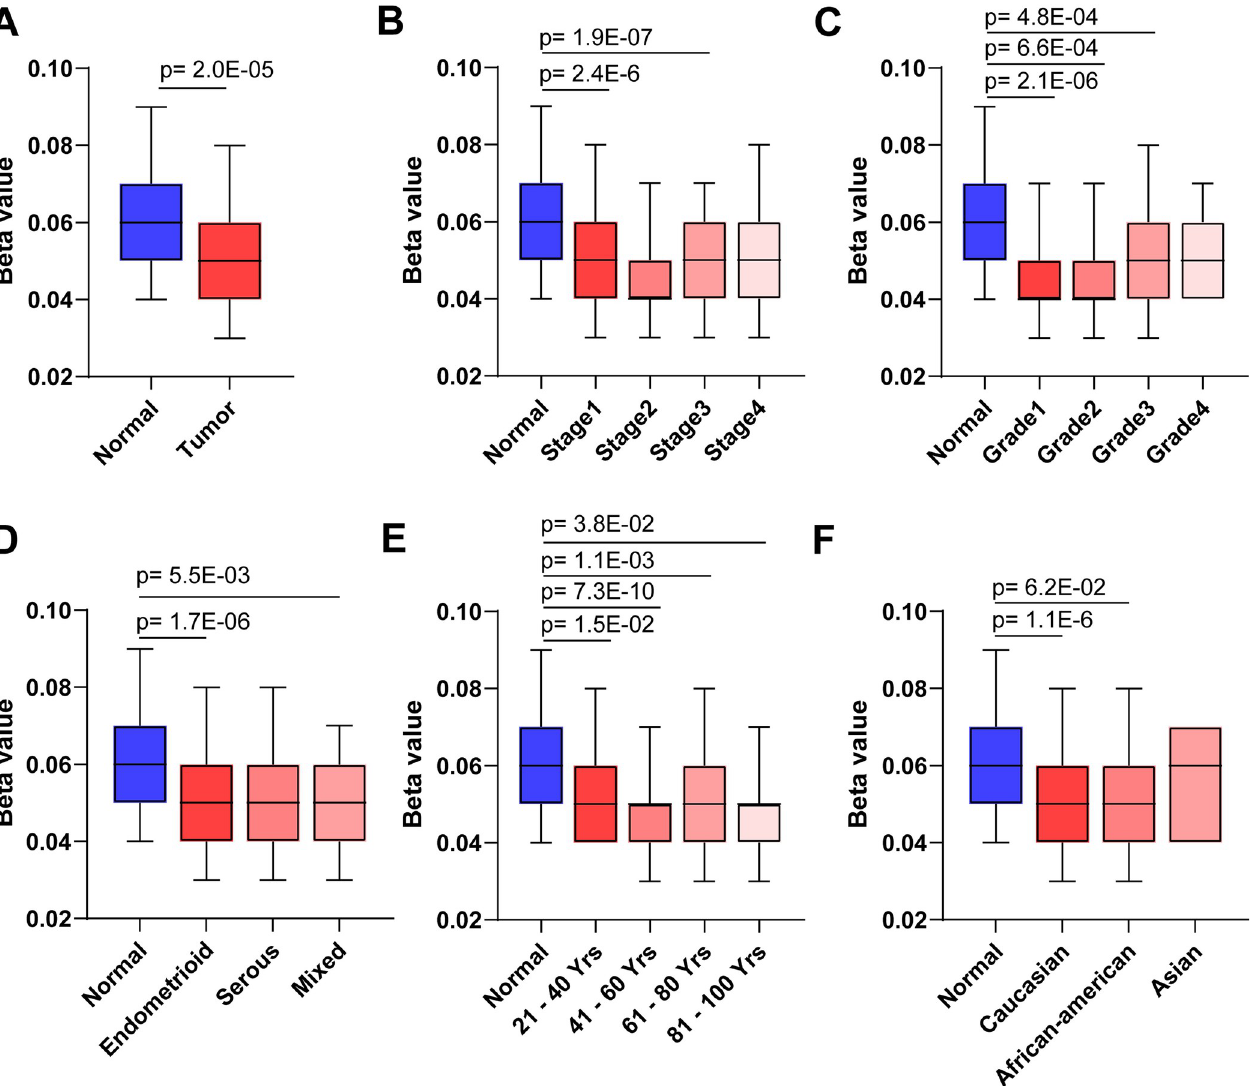
Fig 3. The MYO5B promoter is under-methylated in UCEC patients. The methylation status of the MYO5B promoter as denoted by beta-score in the following groups: A. normal and grouped UCEC tumor samples; B. stage 1, 2, 3 and 4 UCEC tumors; C. tumor grade, D. endometroid, serous, or mixed tumor types; E. patient age; F. menopause status, or patient